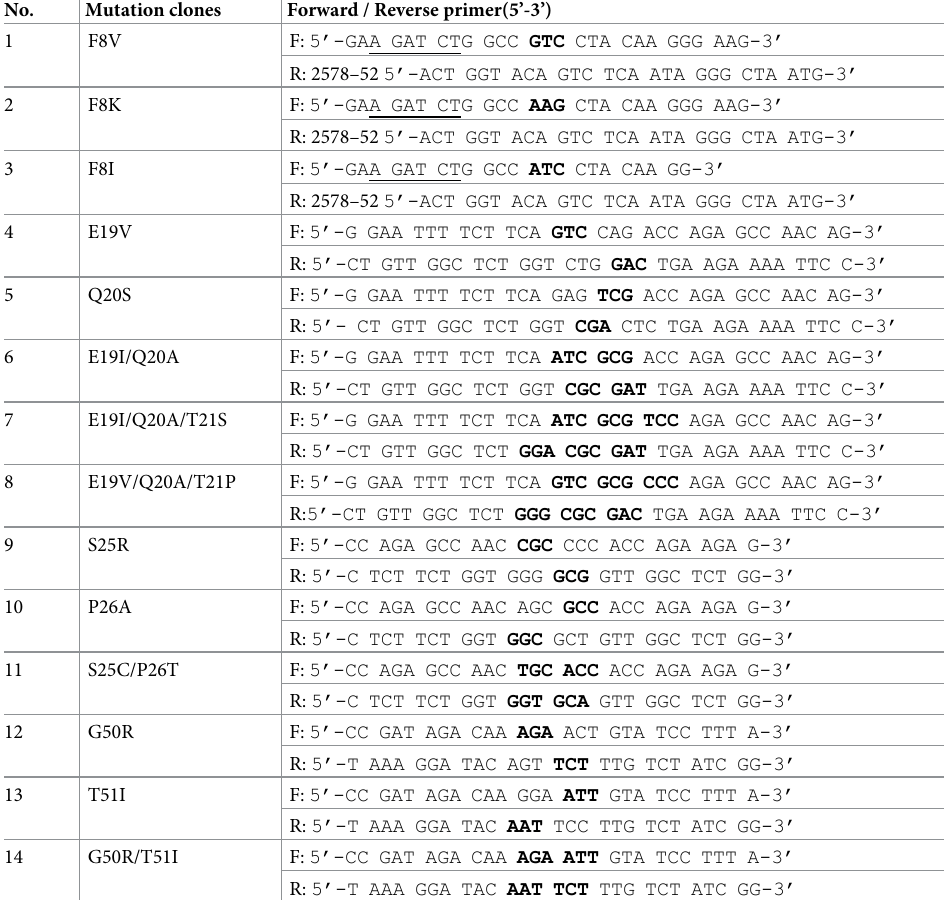
Table 1. Primers used for creating p6 � residue substitution